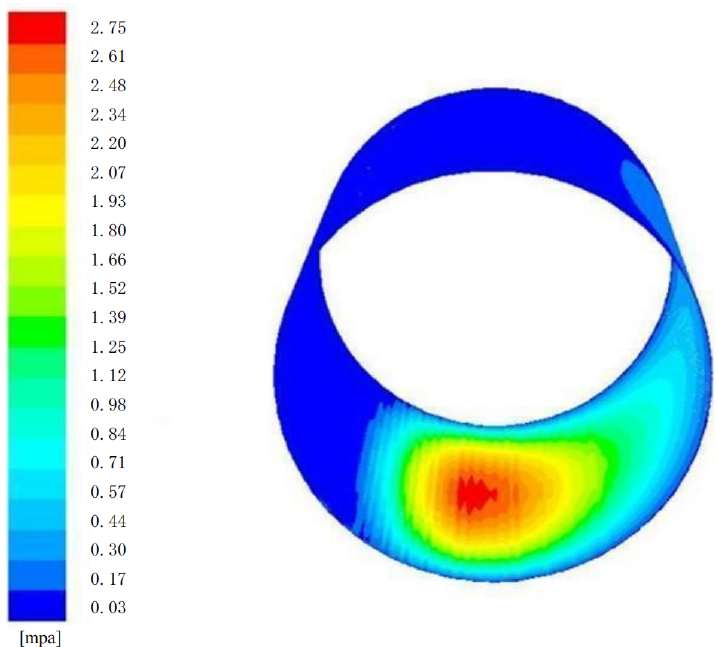
Figure 3. Oil film pressure distribution considering cavitation effect: Oil pressure